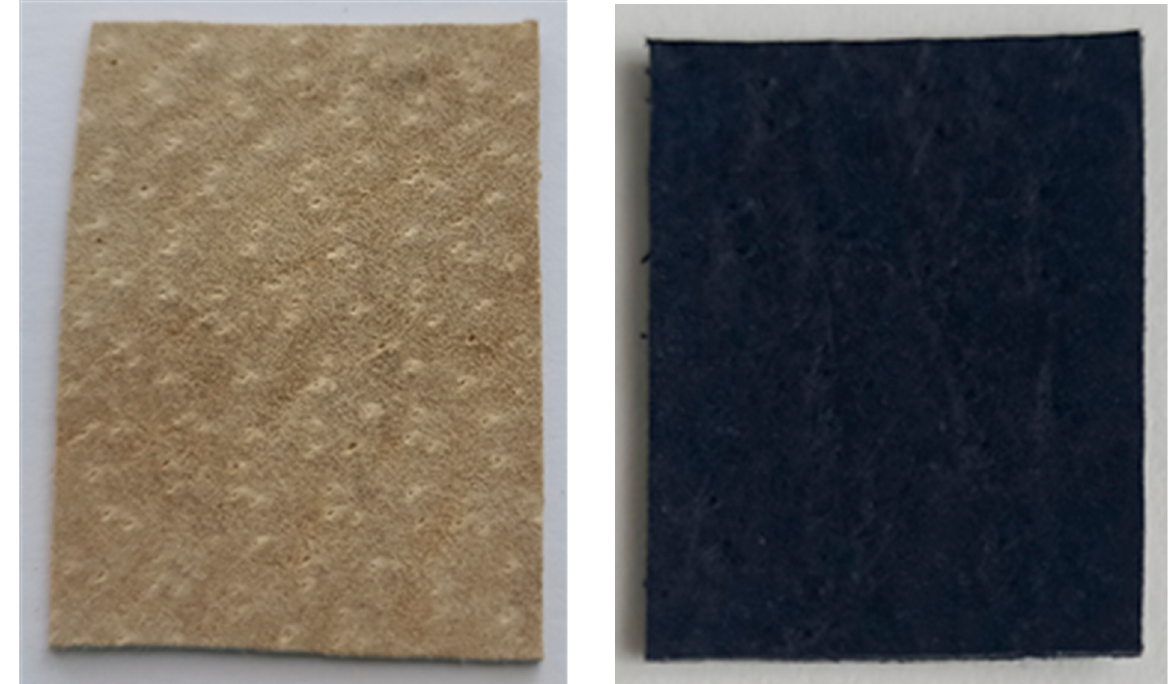
Figure 3. Front of the original leather ( left ) and leather coated with polypyrrole in the presence of PVP and crystal violet dye ( right